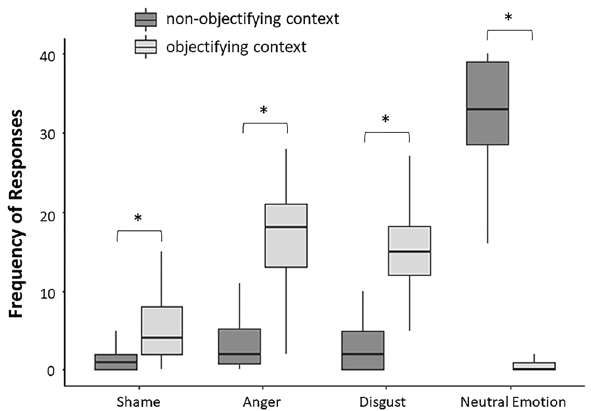
Figure 1. Behavioural results of the objectification task. Frequency of responses as a function of emotion (shame, anger, disgust and neutral emotion) and objectification condition (objectifying and non-objectifying context). (*) indicates significant differences ( p < 0.05).